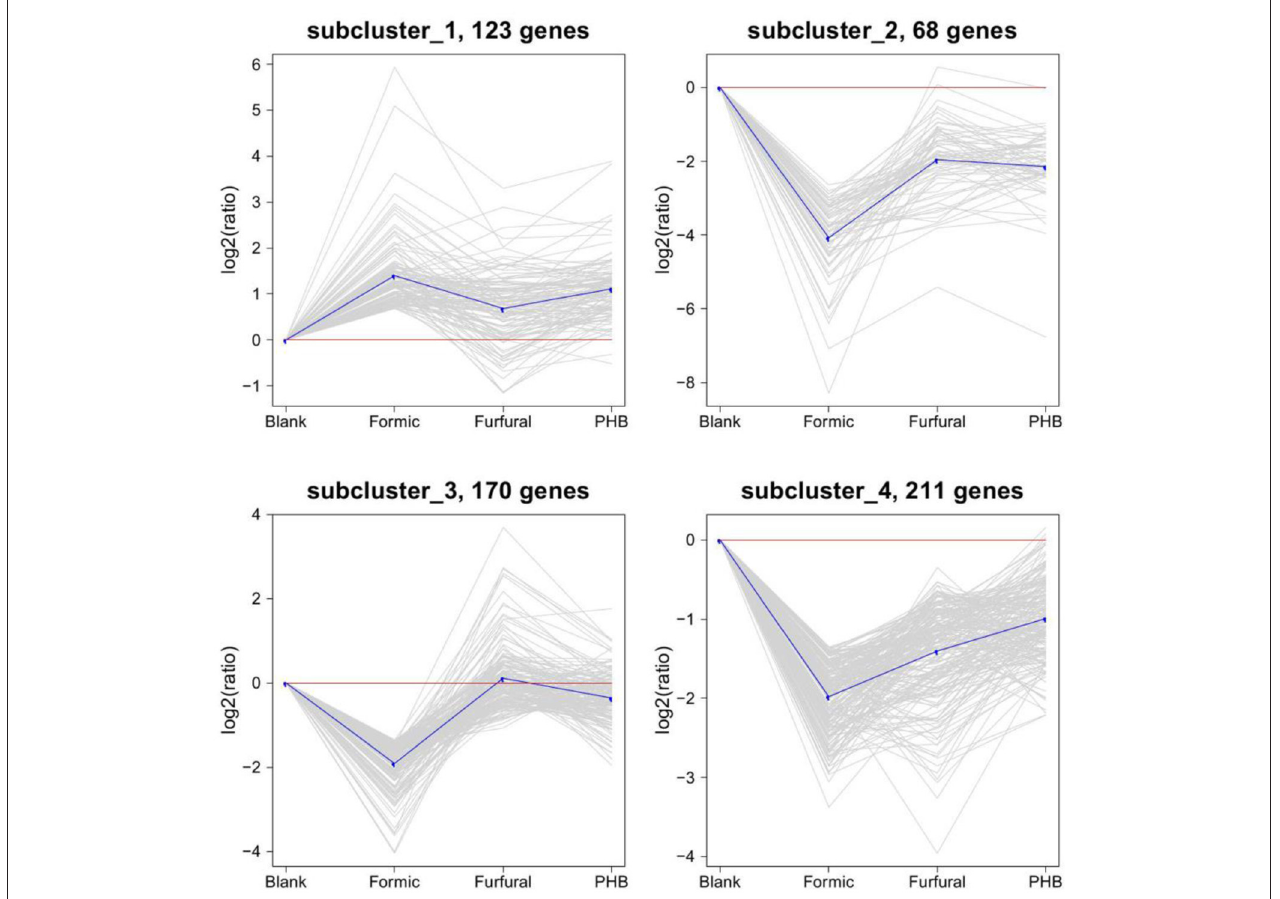
FIGURE 3 | Clustering of the differentially expressed genes. The four major clusters obtained by the K-means algorithm. Expression ratios are expressed as